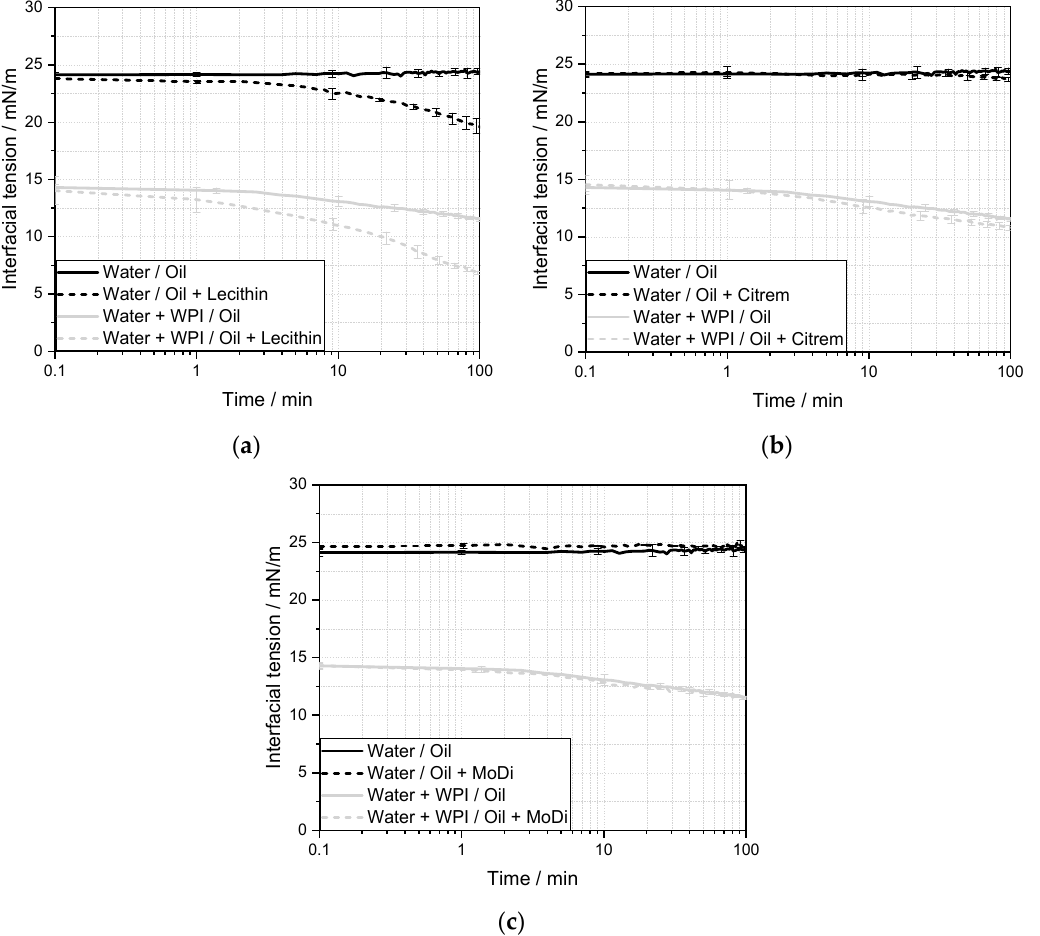
Figure 5. Measurements of interfacial tension over time between oil and water phases with different emulsifiers measured with the pendant drop method for 100 min. ( a ) Oil phase with added lecithin. ( b ) Oil phase with added citrem. ( c ) Oil phase with added mono and diglycerides (MoDi).